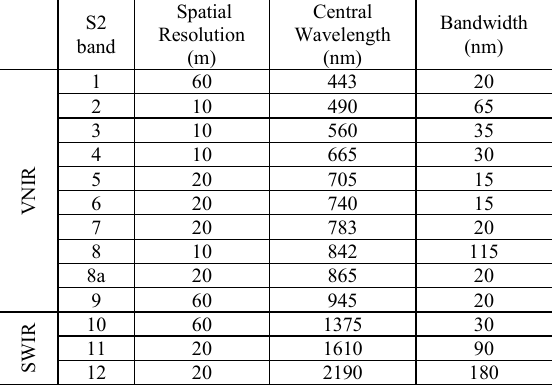
Table1. .Spatial and spectral characteristics of sentinel 2A bands